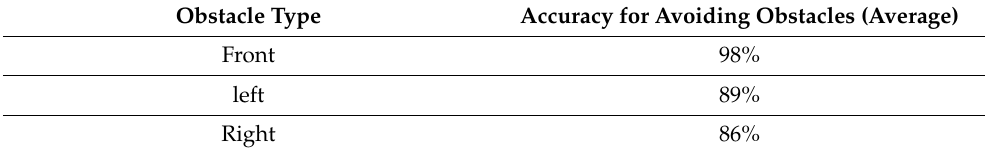
Table 7. Successful detection of obstacle